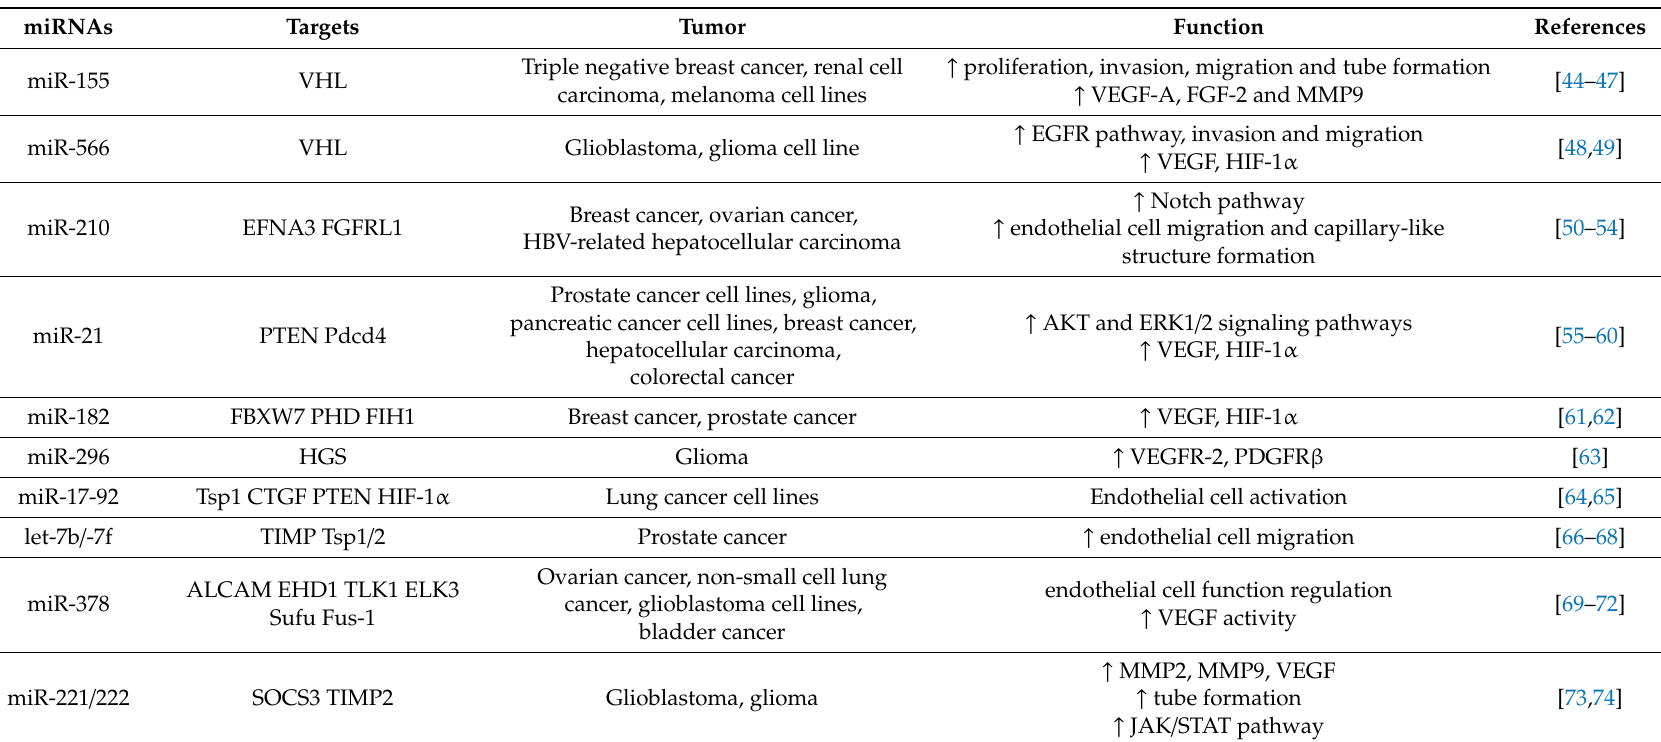
Table 1. Summary of pro-angiogenic miRNAs involved in tumor angiogenesis